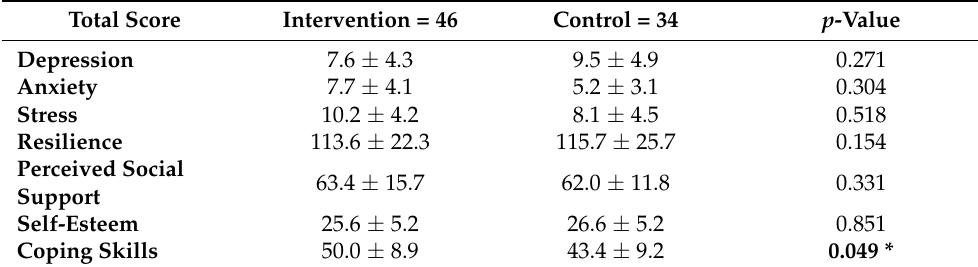
Table 4. Baseline mental health status, resilience, perceived social support, self-esteem, and coping skills of participants between